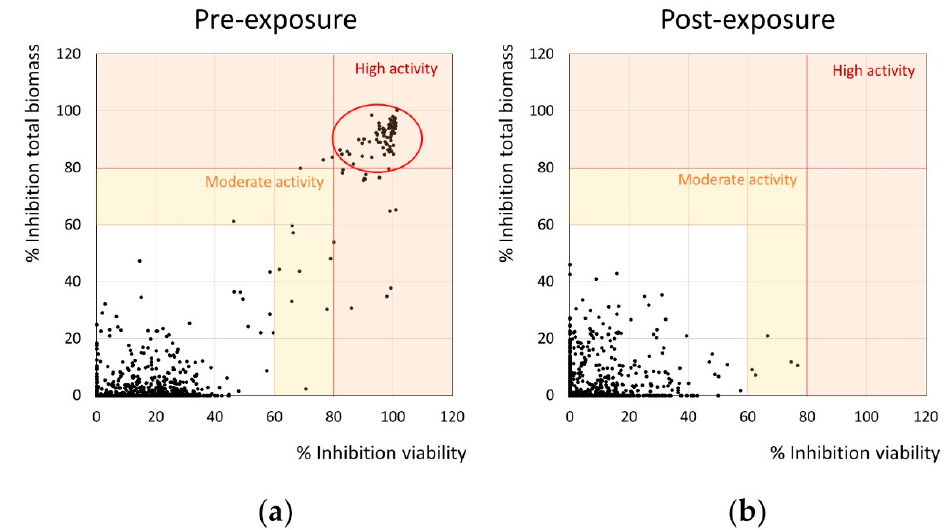
Figure 9. Results of the screening of a compound library of 2000 compounds tested at 10 µM against S. aureus biofilms grown in 384WP. ( a ): prevention of biofilm formation (pre-exposure). ( b ): destruction of 18h-old pre-formed biofilms (post-exposure). The effect of the compounds on the biofilms was assessed by resazurin (x axis) and crystal violet (y axis) staining. The red lines represent the inhibition thresholds used to select active compounds. Results are expressed as inhibition percentages of viability or biomass in comparison to untreated biofilms and they are based on two independent biological replica experiments.